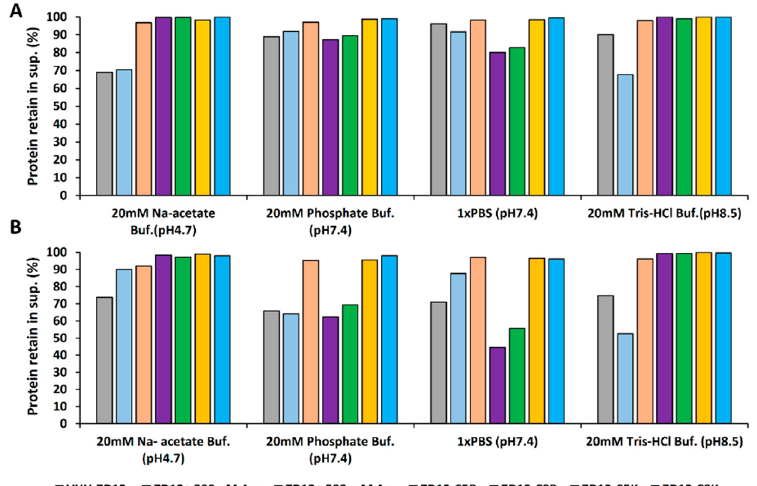
Figure 4. High-temperature thermal aggregation suppressive behavior of V HH -7D12 variants. High-temperature thermal aggregation behavior was analyzed at 60 and 75 °C, where half and all of the V HH s were unfolded, respectively. 0.5 mg/mL of proteins in four different buffers were heated for 45 min. After heat incubation, the samples were centrifuged at 20,000× g for 20 min. The amount of supernatant protein was measured just before and after heat-incubation by absorption at 280 nm to calculate the percent of the protein that formed insoluble aggregates (precipitate). Percent of protein retained in the supernatant after heat stress of tagged and untagged V HH -7D12 at ( A ) 60 °C and ( B ) 75 °C. Experiments at 60 °C and 75 °C were performed on the same day and using the same lot of protein. Table 2. Amount of protein (%) retained in the supernatant after thermal stress.